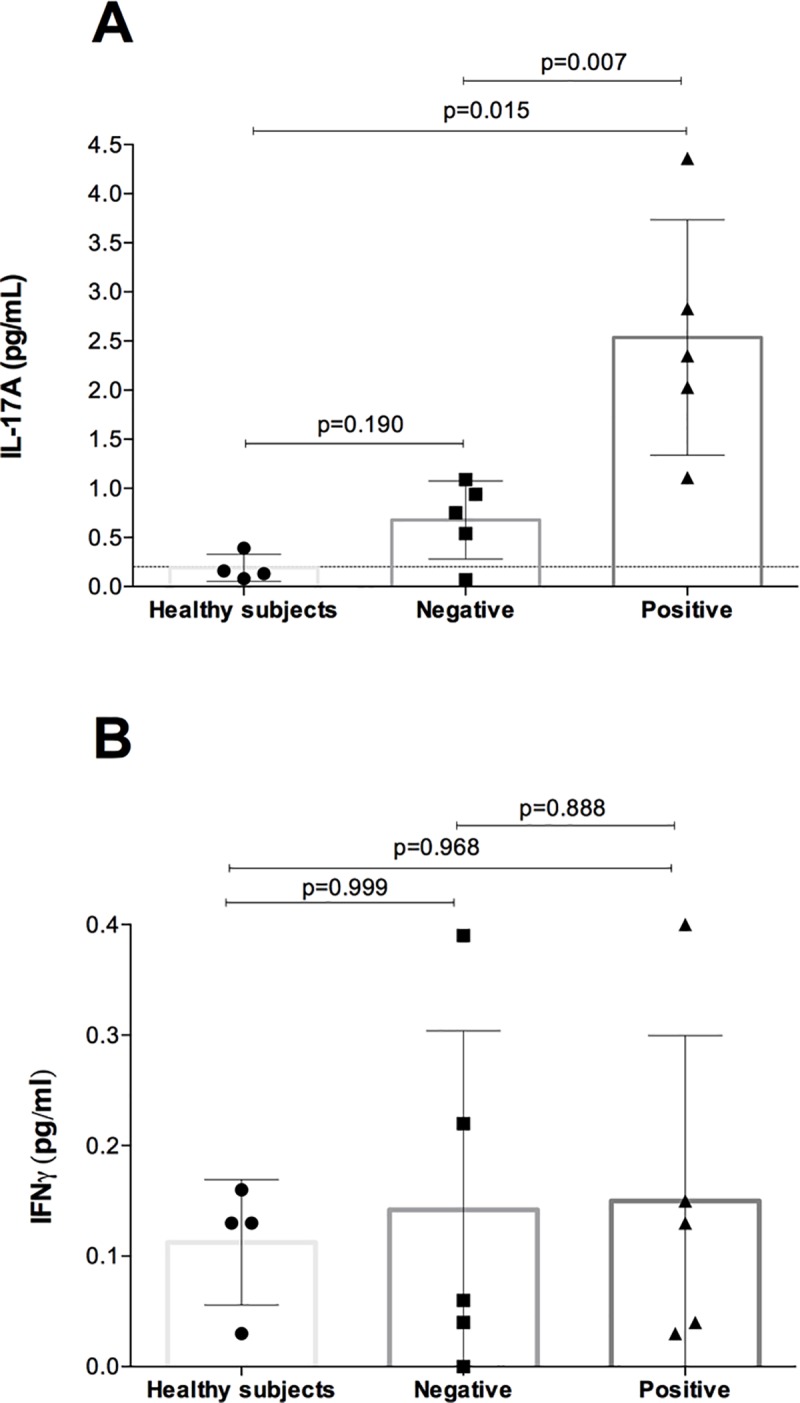
Plots showing IL-17A and IFN-y plasma values among five patients included.(A) Patients with positive AAb showed higher levels of IL17A compared to those with negative pancreatic AAb and the healthy controls. (B) Plot showing IFNy among different groups.